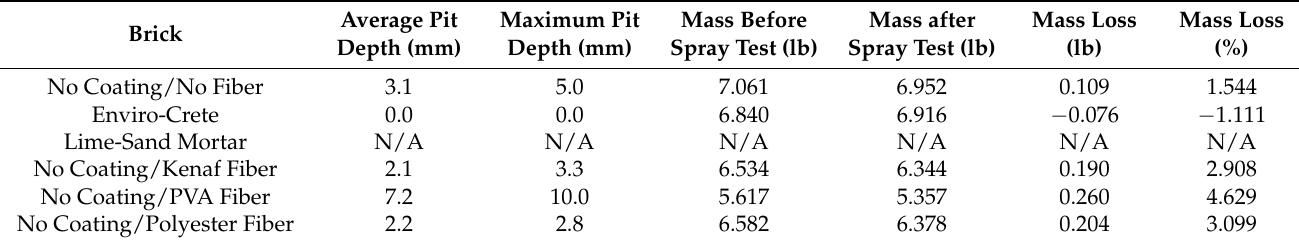
Figure 5. CSEB before and after erosion test. Table 2. Results from erosion test on uncoated and coated bricks. Table 2. Results from erosion test on uncoated and coated